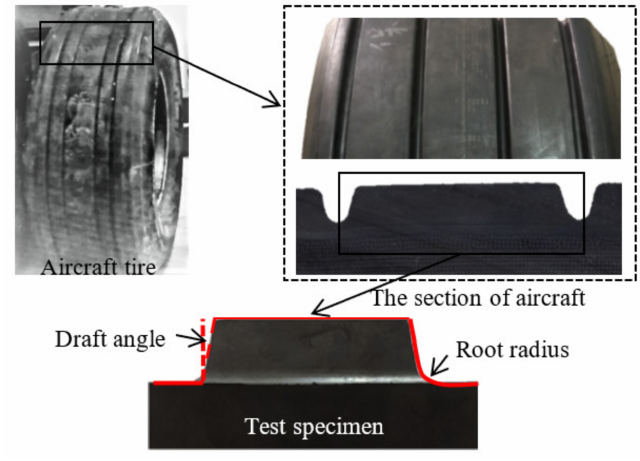
Figure 1. Geometry of the aircraft tire groove.